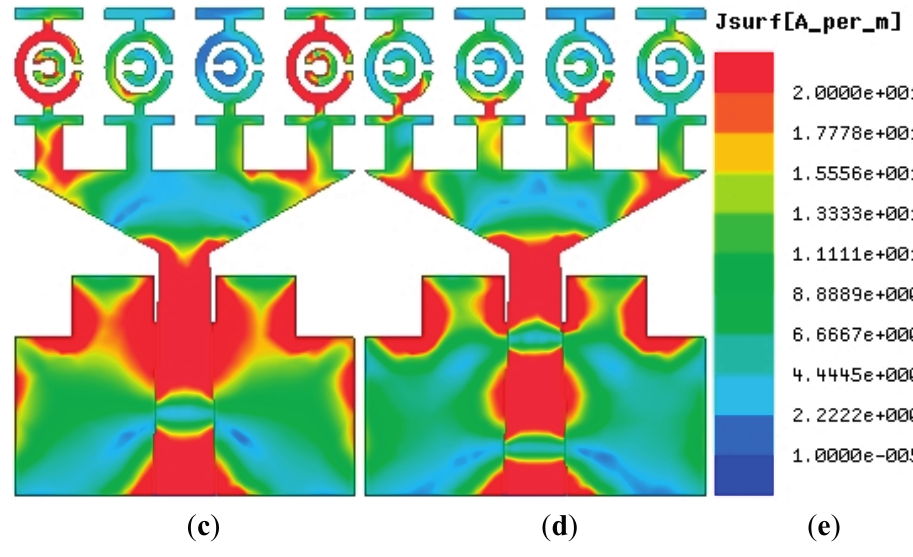
Figure 17. The surface current distribution at ( a ) 4 GHz; ( b ) 6 GHz; ( c ) 8 GHz; ( d ) 10 GHz; ( e )